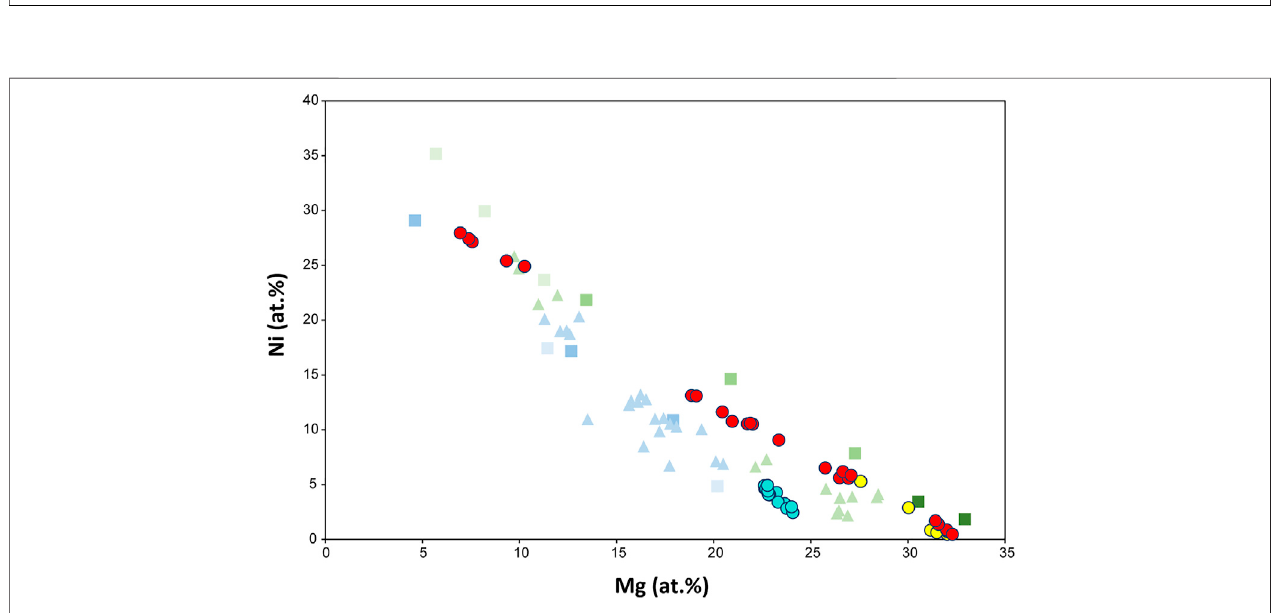
FIGURE6| Nickelcontentofgarnierite samplesfrom thisstudy and other references asa functionofMg content inatomic percentage. Type ItoVgarnieritesdata are from Villanova-de-Benavent et al. (2014). Serpentine-like and talc-like garnierite data are from Fu et al. (2018). Legend is identical in Figure 5 .